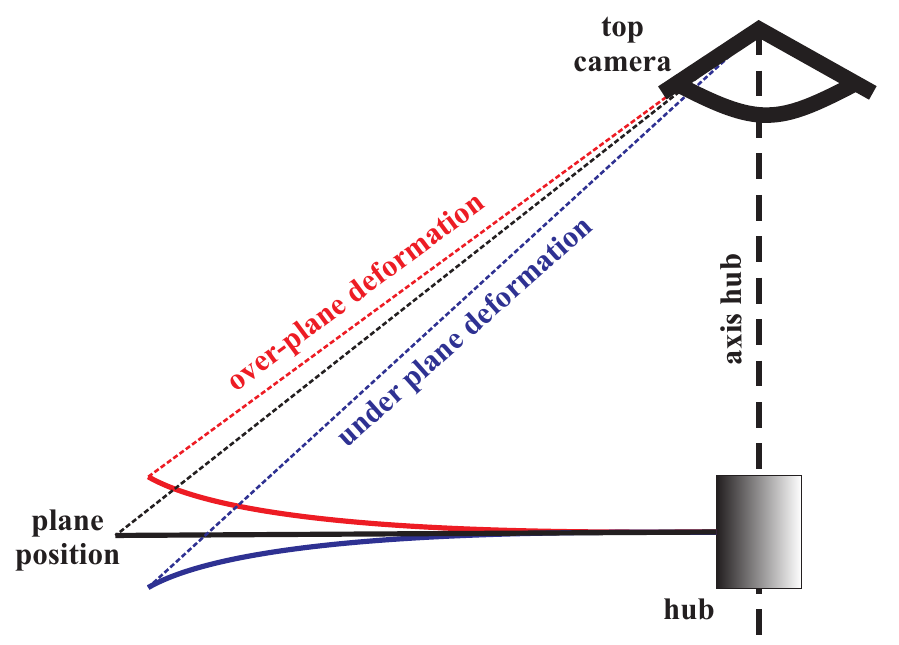
Figure 11. Side view of the top camera axially aligned with rotating hub: the effect of beam deforma- tion outside the rotor plane on camera observation.